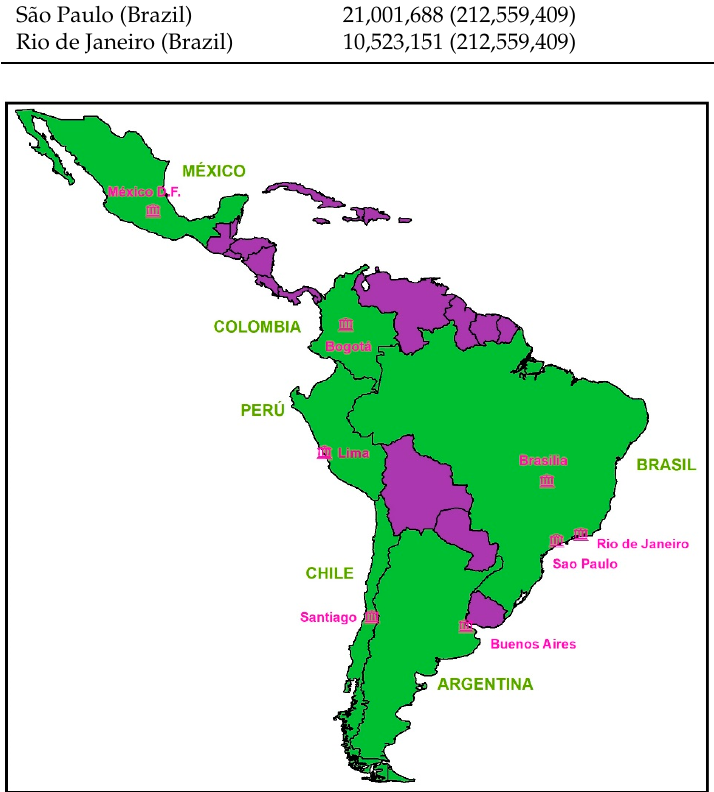
Figure 1. Cities and countries (in green) that are the subject of this article.